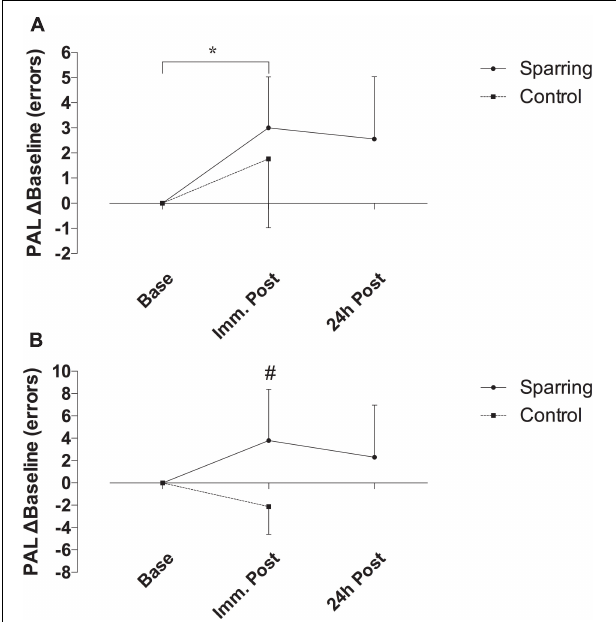
FIGURE 4 | Difference in cognitive performance following sparring or control exercise, relative to baseline. (A) PAL performance was significantly lower following sparring compared to baseline ( p = 0.01), although there was no interaction effect. (B) SWM showed an interaction effects between groups ( p = 0.002), though not significantly different from